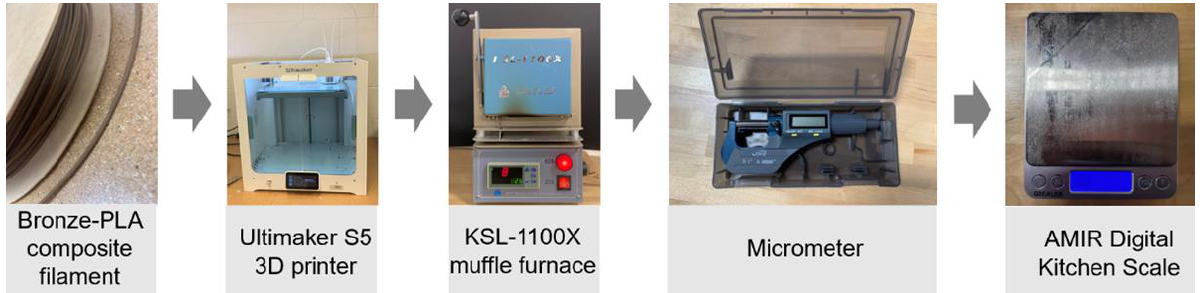
Figure 2. Material and equipment used in this research .